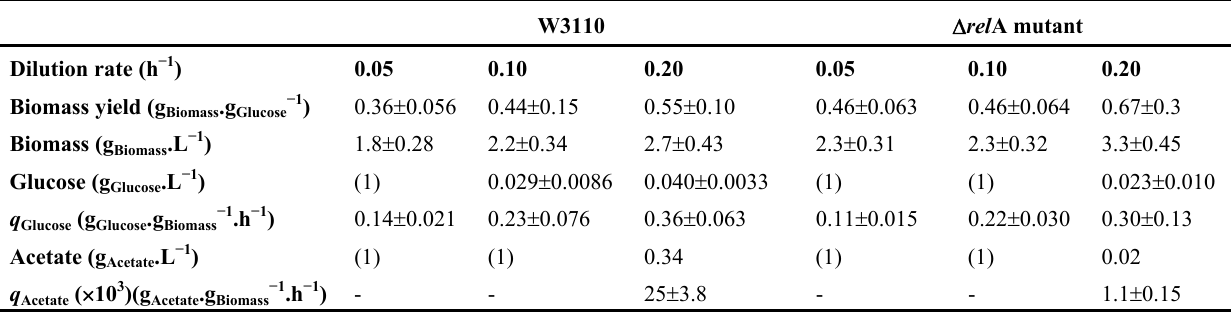
Table 1. Growth parameters of the W3110 and  rel A mutant E. coli strains in aerobic glucose-limited chemostat cultures.